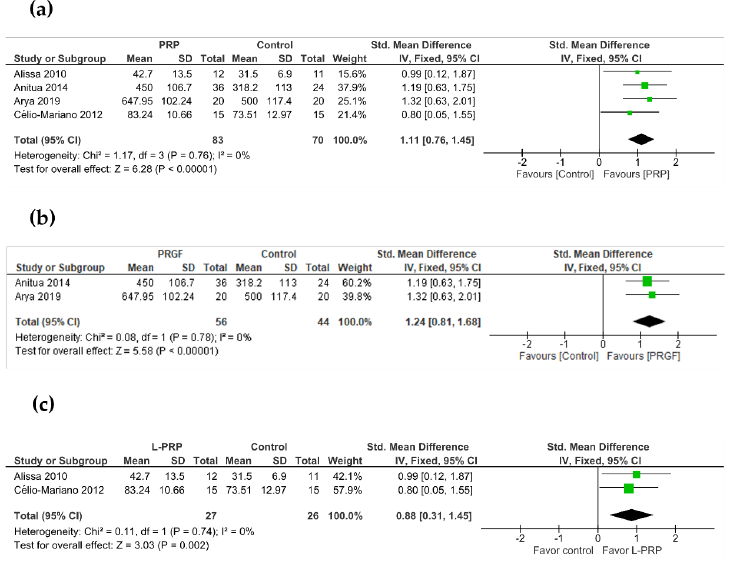
Figure 4. Meta-analysis of the studies evaluating bone density. ( a ) PRP, ( b ) PRGF, ( c ) L-PRP. SE: standard error; SMD: standardized mean difference; CI: confidence interval.